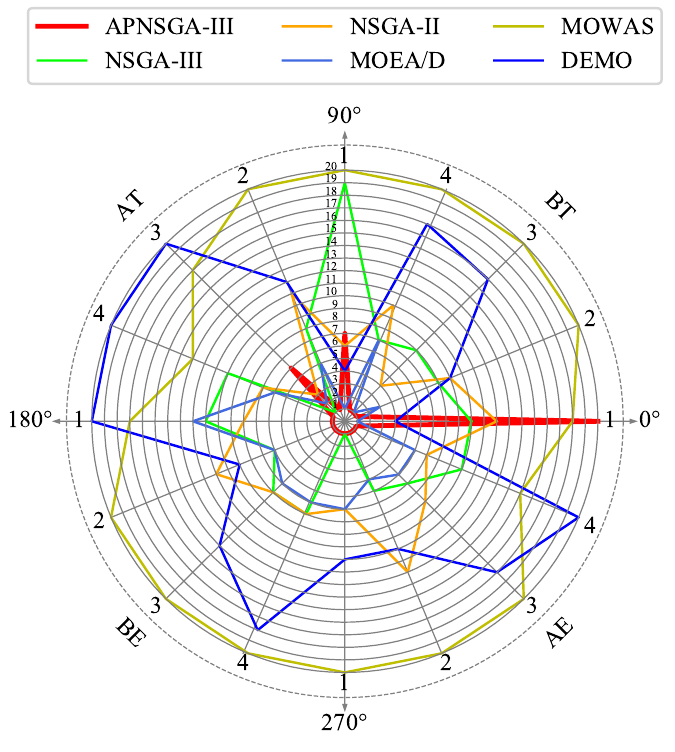
Figure 4. Ranking of six algorithm. Table 11. The results of Instance 1 and Instance 2 (* represents the optimal result).